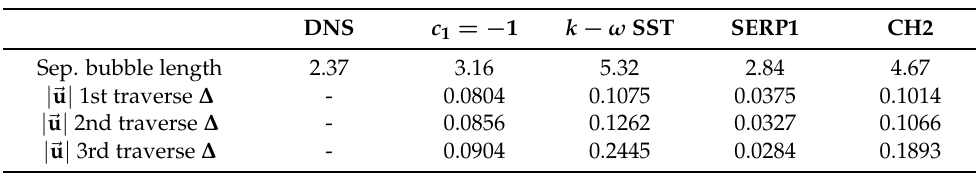
Table 2. Length of the separation bubble in non-dimensional units and discrepancy ∆ between DNS and different models for the serpentine test case.